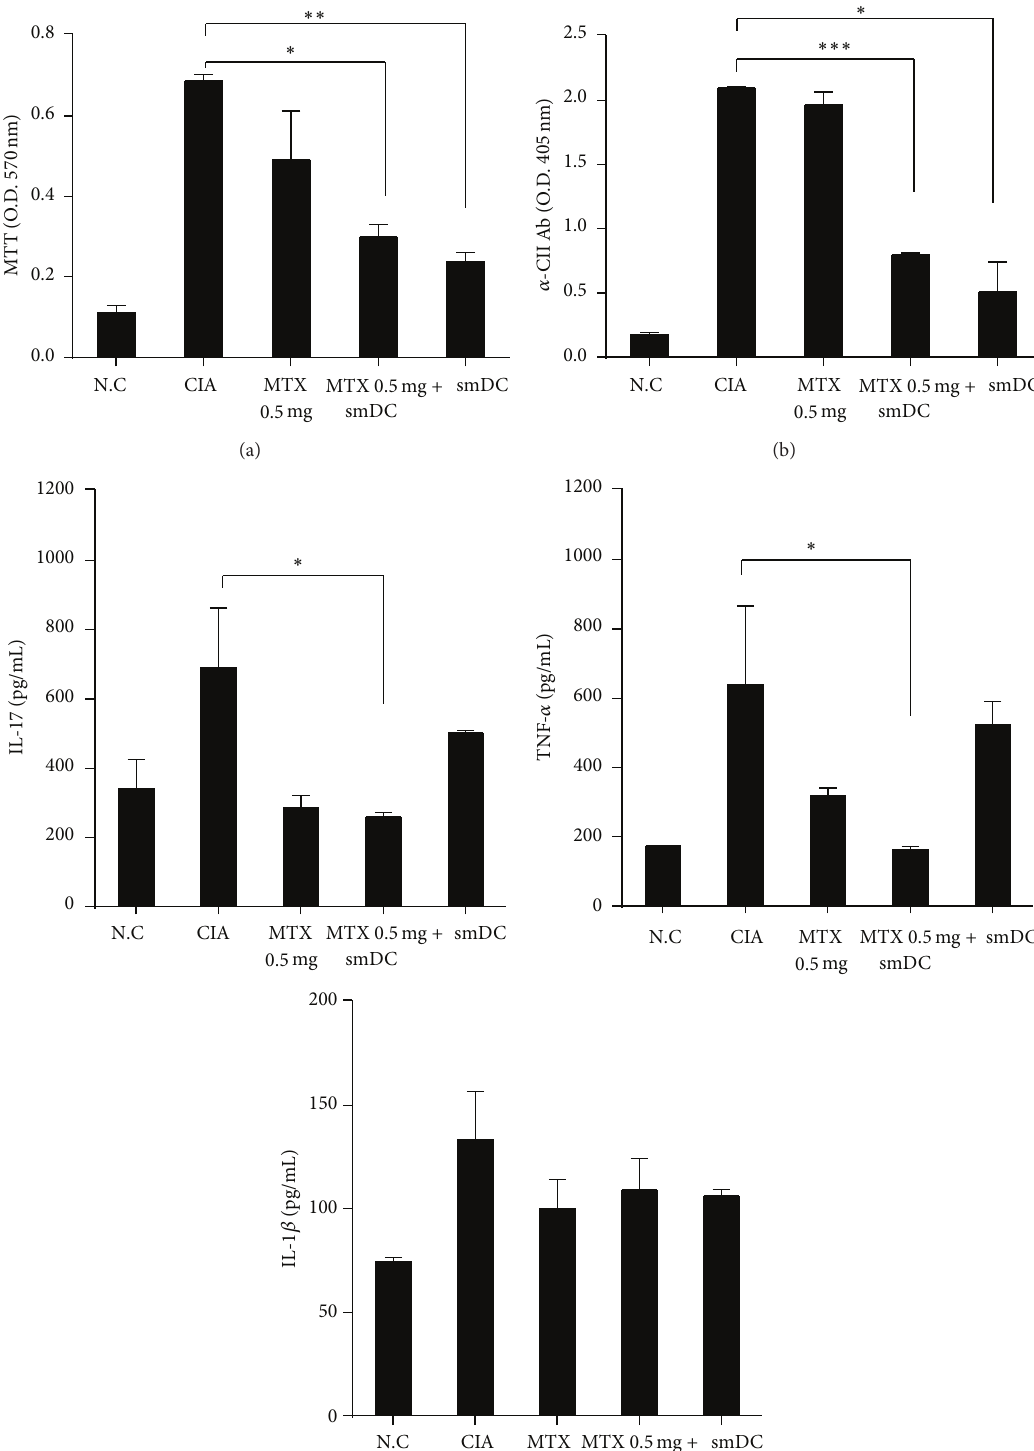
Figure 3: Analysis of CII-specific splenocytes and the levels of CII-specific IgG and proinflammatory cytokines in CIA mice after a combination therapy. (a) Advanced CIA mice were treated with smDCs, MTX, or smDCs and MTX. Splenocytes were isolated from mice on day 77 after first CII injection and stimulated by culturing in the presence of CII (50 𝜇 g/mL) for 72 h. Cell proliferation was measured by an MTT assay. (b) Serum was collected from each mouse on day 77 after first CII injection. Anti-CII antibody (Ab) levels were measured by ELISA. (c) Serum samples were collected from normal controls and CIA mice at 77 days after first CII injection and anti-IL-17, TNF- 𝛼 , IL-1 𝛽 antibody (Ab) levels from serum were measured by ELISA. Statistical data are shown as mean ± SEM from more than 3 different sets of experiments. ∗ 𝑝 < 0.05 , ∗∗ 𝑝 < 0.001 , ∗∗∗ 𝑝 < 0.0001 in Student’s 𝑡